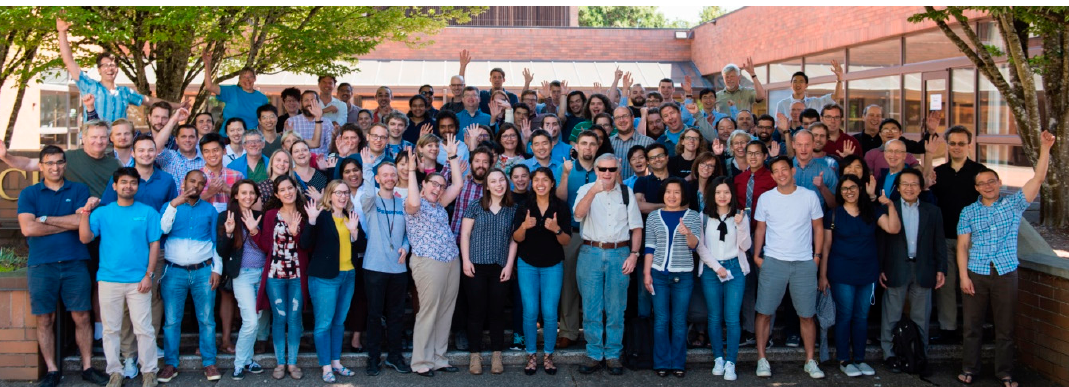
Figure 1. The 2018 GCE Conference at Oregon State University was attended by more than 100 academic and industrial scientists from 12 countries (Photo by Hanna O’Leary from OSU Media Services).